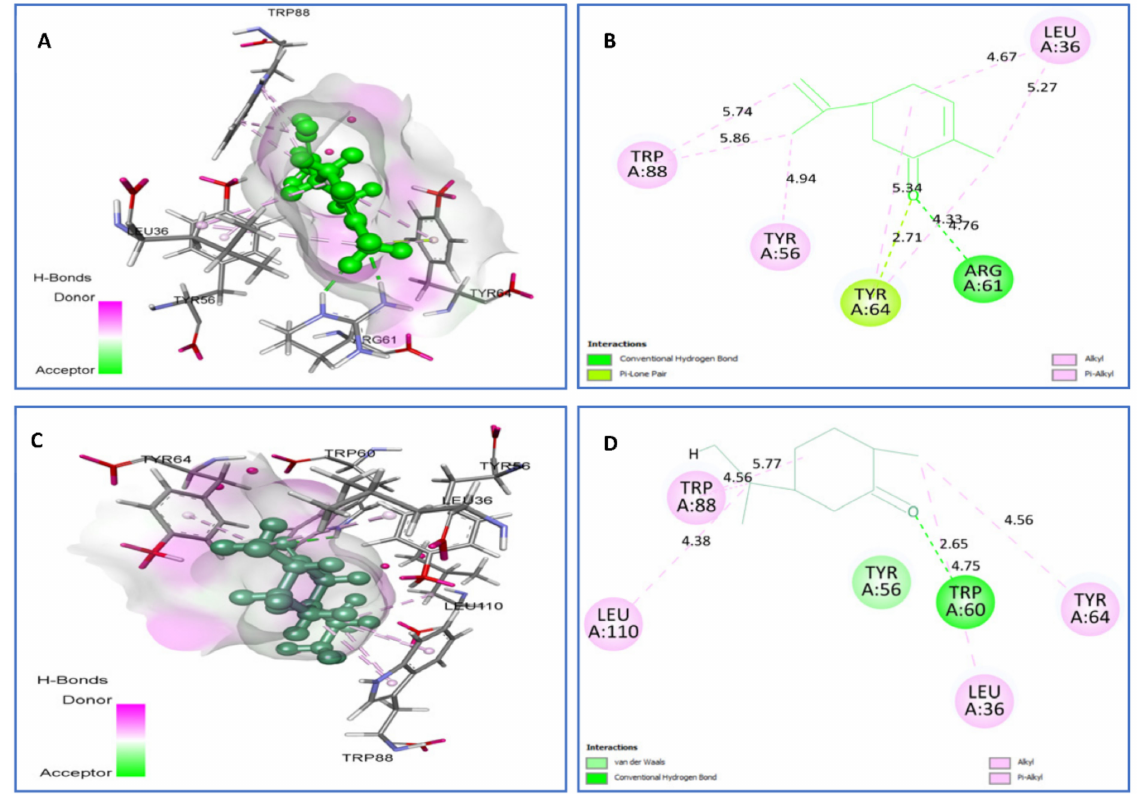
Figure 9. Two-dimensional (2D) and three-dimensional (3D) residual interactions network of carvone ( A , B ) and trans -dihydrocarvone ( C , D ) with the active site of LasR enzyme (PDB ID,